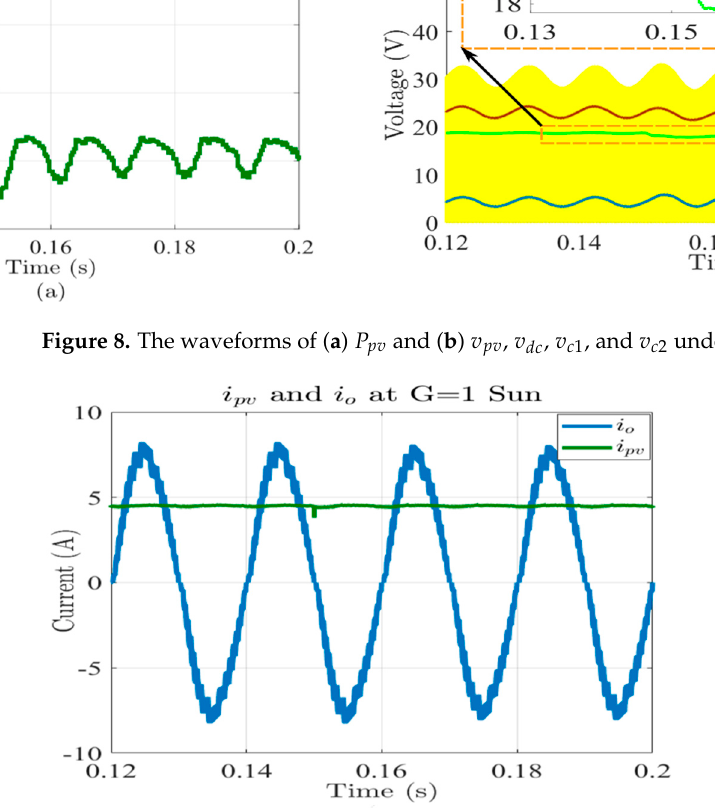
Figure 9. The simulation results of 𝑖 (cid:3043)(cid:3049) and 𝑖 (cid:3039)(cid:3042)(cid:3028)(cid:3031) under changing